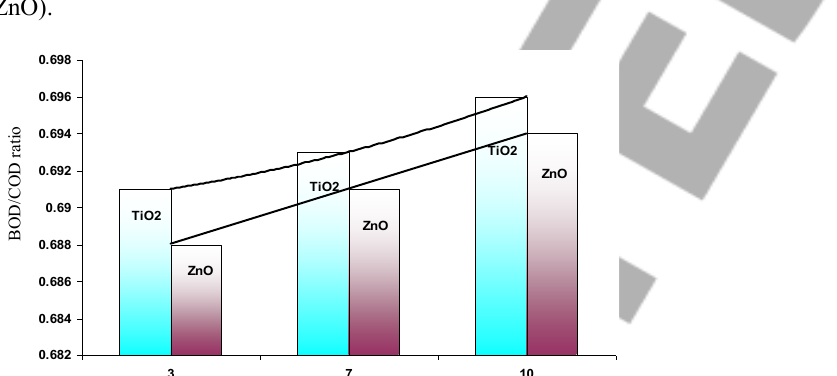
and ZnO at different pH (power=70watt, concentration= 2